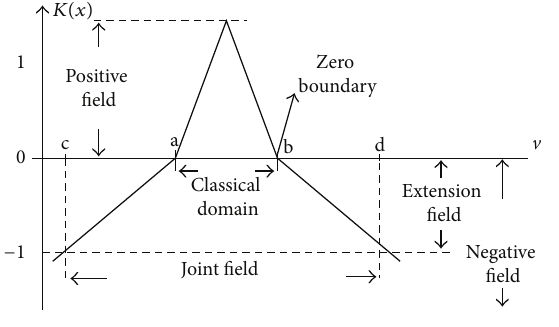
Figure 4: Extended correlation function.